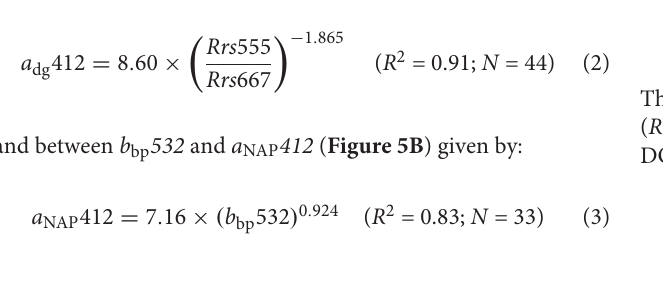
( Figure 5A ) given